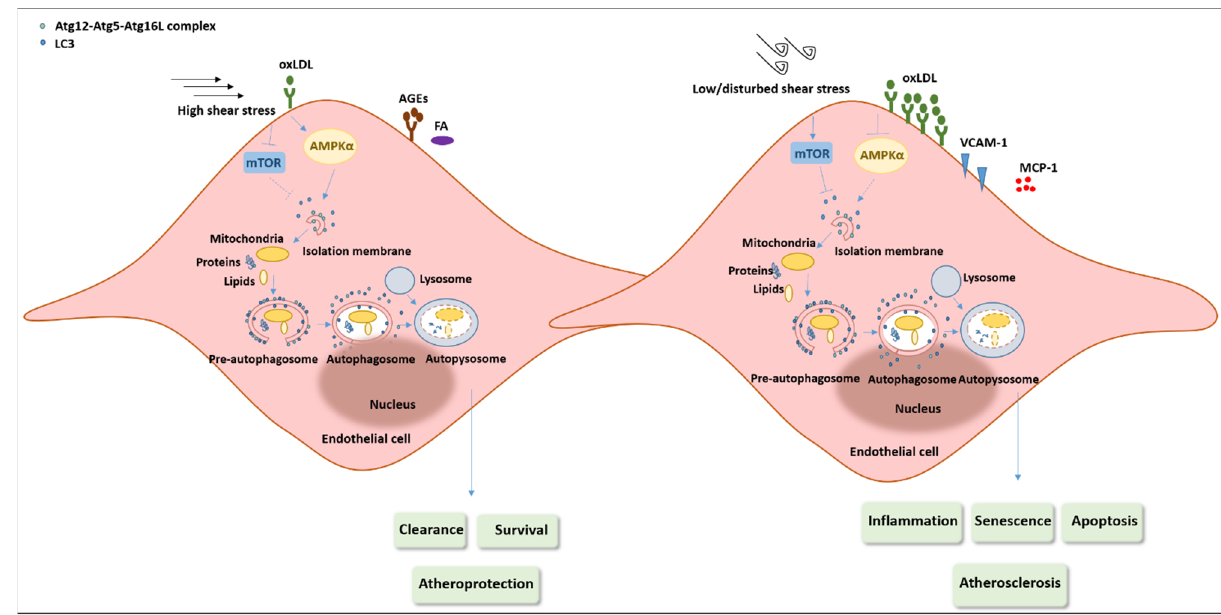
Figure 3. Role of autophagy in endothelial cells during atherosclerosis. Different atherogenic stimuli, such as oxLDLs, AGEs, and saturated FA, can stimulate autophagy/mitophagy in ECs. Additionally, exposure to high shear stress can promote protective autophagy in ECs, playing antiapoptotic, antisenescent, anti-inflammatory, and antiatherogenic roles. Conversely, the exposure of ECs to low and disturbed levels of shear stress as well as oxLDL accumulation impairs autophagic flux as a result of inhibition of the AMPK α pathway and activation of the mTOR pathway as well as the blockade of fusion between autophagosomes and lysosomes. Defective autophagy leads to hyperactivation of inflammasomes, defective cholesterol efflux, and senescence and apoptotic cell death, thus exacerbating the atherosclerotic process. Solid lines indicate upregulated pathways. Dashed lines indicate downregulated pathways. AGEs: advanced glycation and products; ECs: endothelial cells; FA: fatty acids; MCP-1: monocyte chemoattractant protein-1; oxLDL: oxidized low-density lipopro- teins; VCAM-1: vascular cell adhesion protein-1.